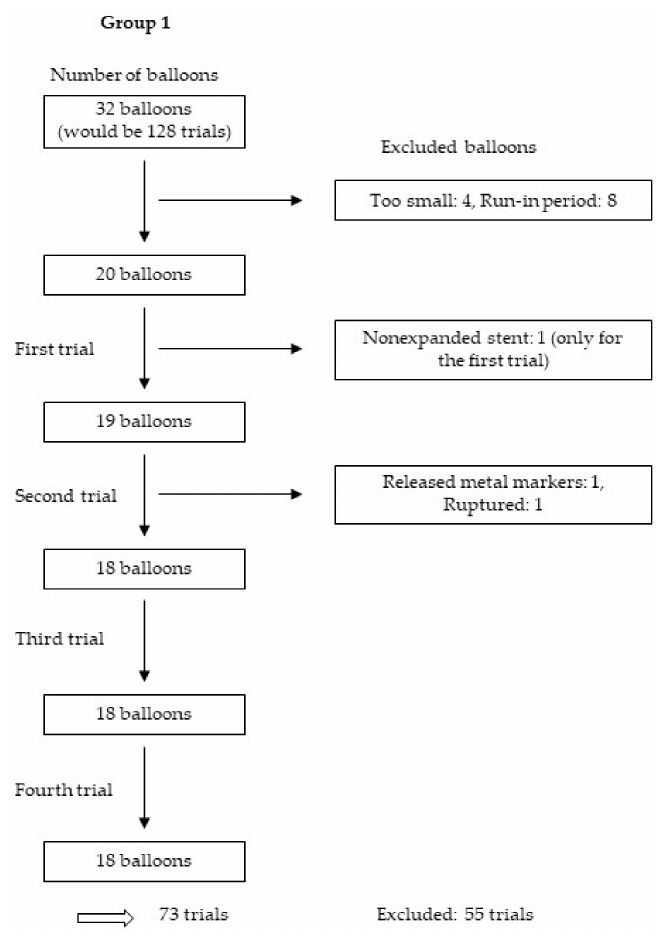
Figure 5. Excluded balloons group